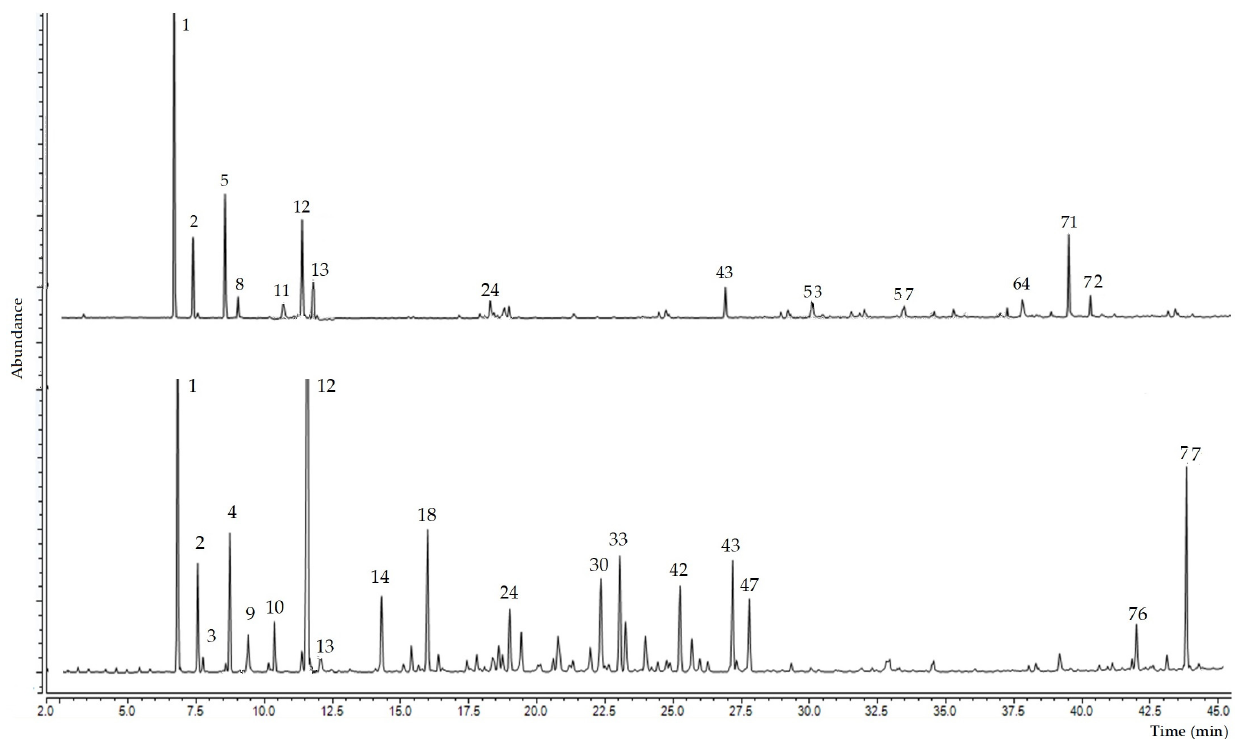
Figure 1. Representative chromatograms of the essential oil from leaves (upper) and fruits (lower) of Siparuna muricata . The numbers correspond to the compound numbers in Table 1.